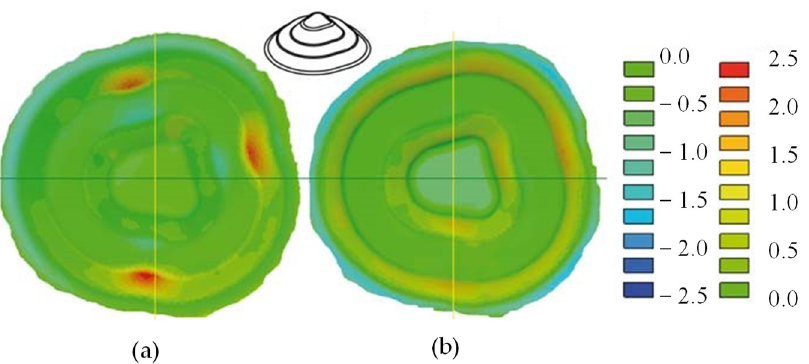
Figure 15. Geometric accuracy at the ( a ) DSIF-P ( b ) DSIF-L process (reprinted with permission from Meier et al. [37], Copyright 2011 Elsevier).